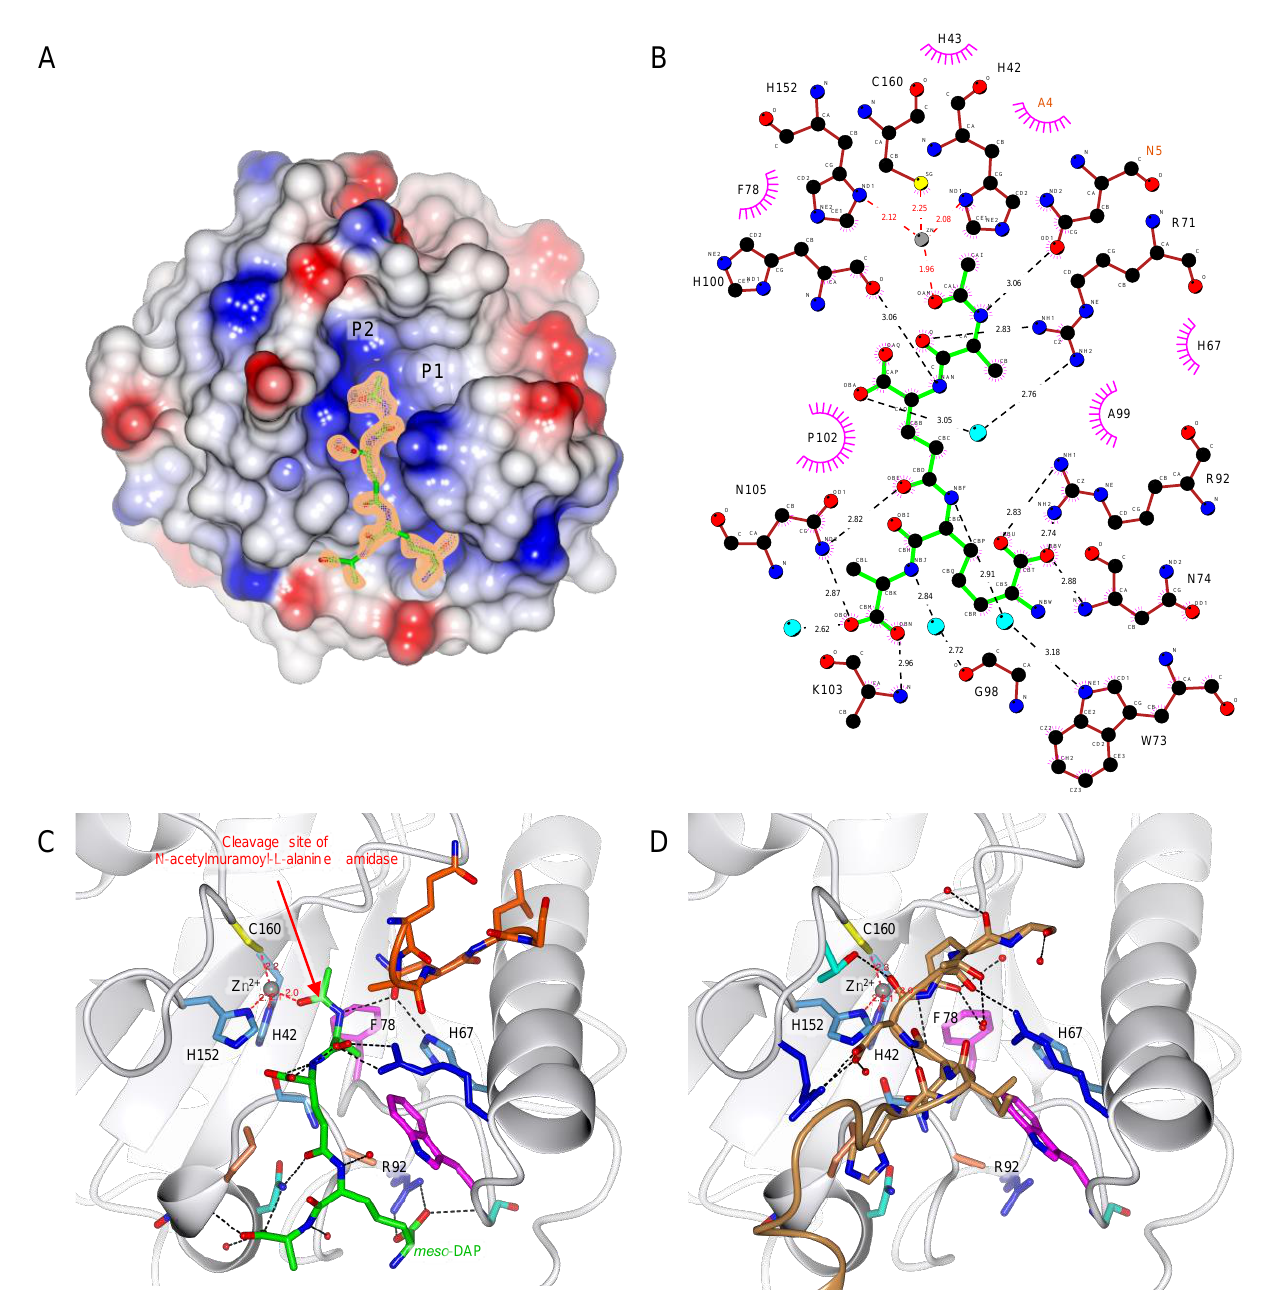
Figure 3. TCT binding to Drosophila PGRP-LB PA/PC . ( A ) Overall structure of Drosophila PGRP-LB PA/PC complexed with TCT (PDB 7NT0). The surface of the protein represents its electrostatic potential, positive potential is represented in blue and negative in red. The TCT is represented in green, and the initial F o -F c electron density at 3σ is shown around the TCT. P1 and P2 are possible pockets for the sugar moiety. ( B ) TCT hydrogen bonding network. TCT is represented in green, hydrogen bonds are represented in black dotted lines, red dotted lines show the Zn 2+ (grey ball) chelation and hydrophobic interactions in the pink circle. The residue belonging to the symmetry-related molecule are annotated in orange. ( C ) Interaction of the TCT within the binding pocket. TCT is shown in green, and the protein is in ribbon representation with side chains of the TCT-interacting residues shown according to their residue property. Hydrogen bonds are represented in black dotted lines; red dotted lines show the Zn 2+ (grey ball) chelation. The symmetry related chain of 5 residues is colored in orange. The red arrow indicates the cleavage site of the amidase PGRPs ( D ) TCT binding pocket in the apo protein, the symmetry-related molecule represented in brown is filling the site of the TCT. The structure figures were made using CCP4mg [33] and the interaction diagram with LigPlot+ [35].